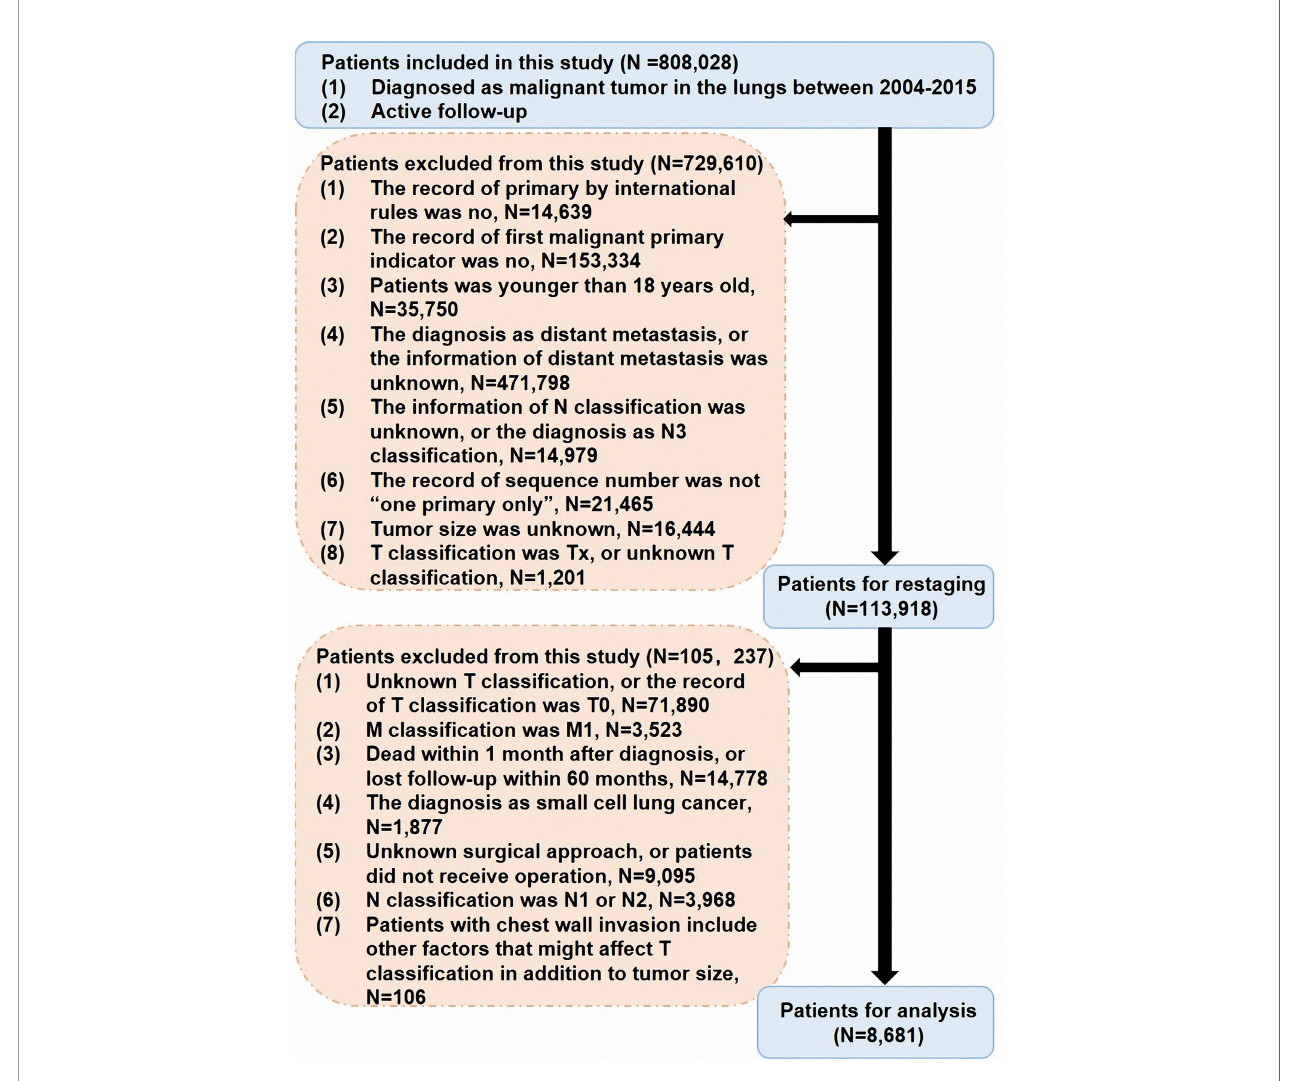
FIGURE 1 | The fl ow chart of this